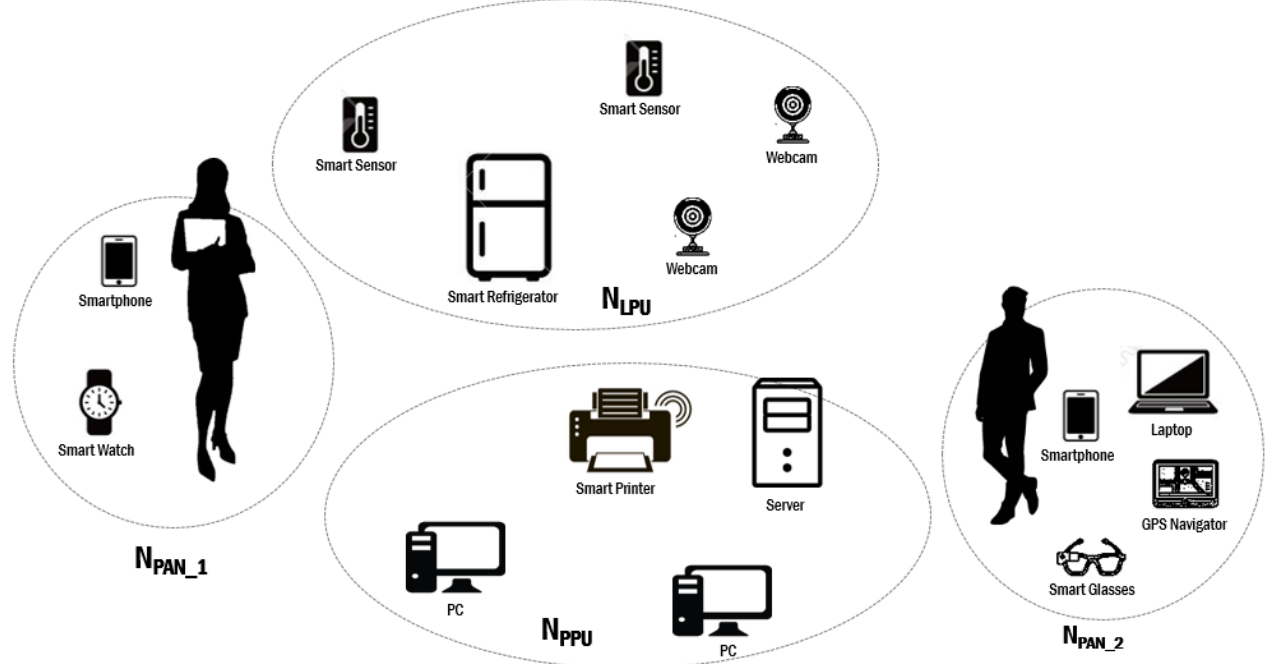
Figure 1. A representation different nodes’ groups in H2O